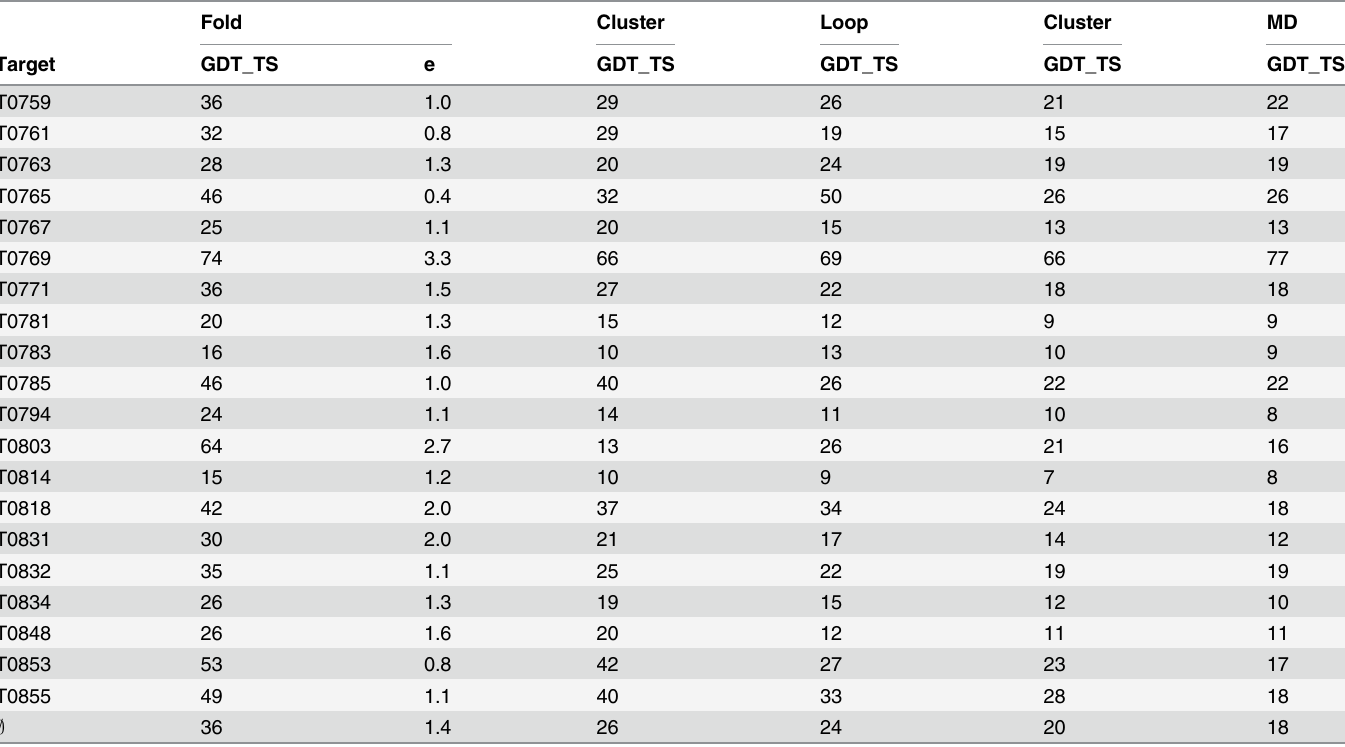
Table 2. Model accuracy decay over the course of the pipeline.